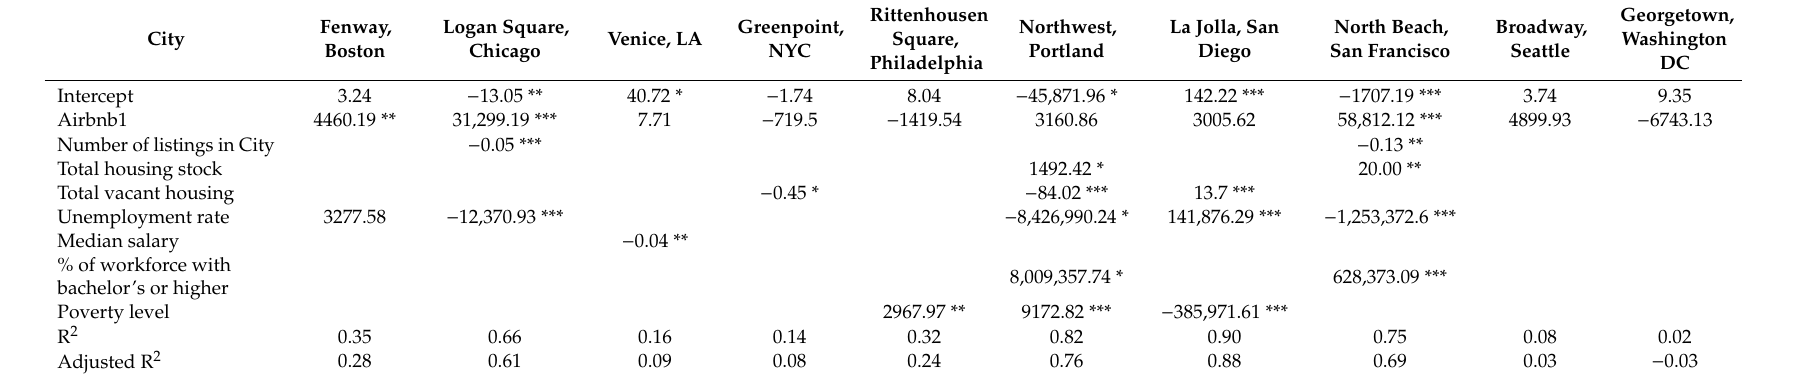
Table 6. Results using Airbnb density as a proportion of the total supply of housing.